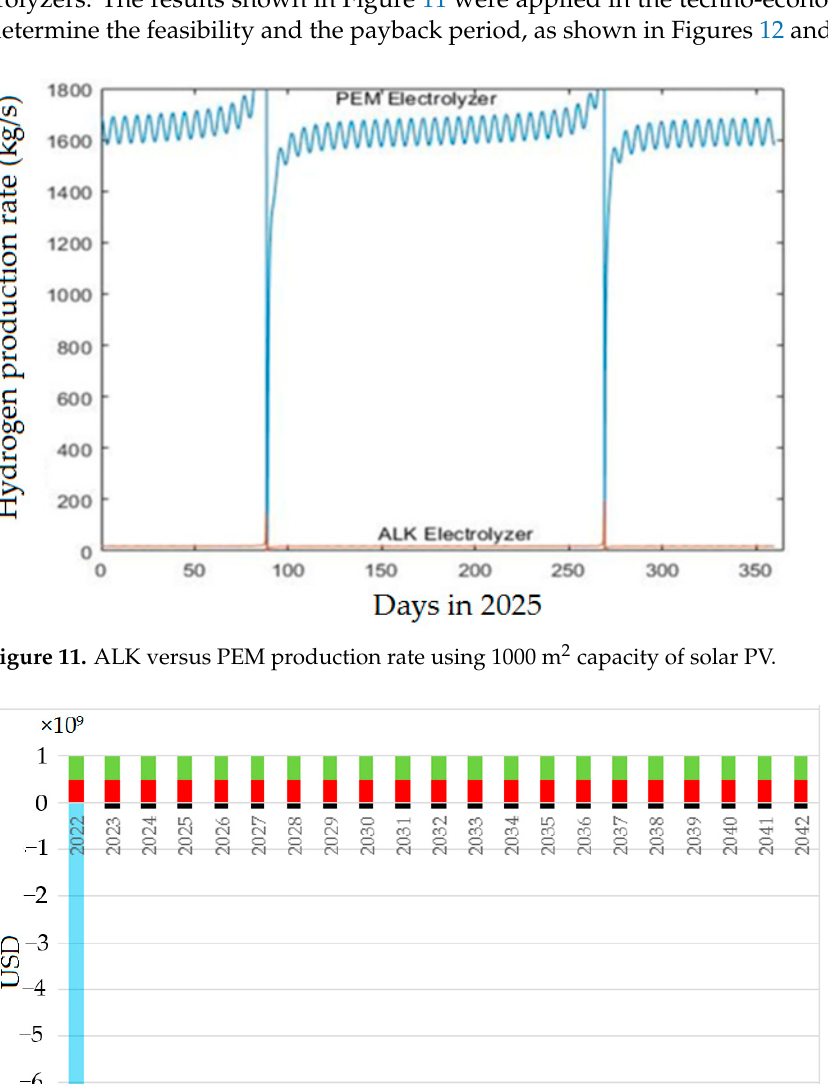
Figure 13. Payback period, net present value, and CO 2 emissions saving. 4.3. Techno-Economical Model Results The economical result was based on the rate of hydrogen production in the ALK elec- trolyzer being 10 kg/s for 5.4 h per day throughout the year, thus producing 194,400 kg/day. For the given initial conditions and the MATLAB code sequence, the rated power that must be delivered to the electrolyzer is 2.858 MW. In the first alternative, this power is extracted from the grid at a tariff of 0.21 USD/kWh. The annual energy cost is USD 195.90 million, and the annual production for hydrogen is 70.956 × 10 6 kg. The LCOH in the first alternative, using electricity from the grid, is 4.42 USD/Kg of hydrogen. In the second scenario, green hydrogen was produced based on the electricity generated from PV. The required capacity for the PV to generate the same rate of hydrogen was 14.29 MW, in order to generate 2.858 MW at an efficiency of 20% for the whole PV system. The LCOH was reduced to 3.13 USD/Kg by applying electricity generated from the PV system. In addition, the break-even point under the second scenario, i.e., to cover the capital cost of the PV system, was 11 years of the project life. The NPV under the second scenario was USD 441.95 million, representing the feasibility and potential of this project. Figures 12 and 13 depict the cash flow and the break-even point obtained in the techno-economic study, respectively.